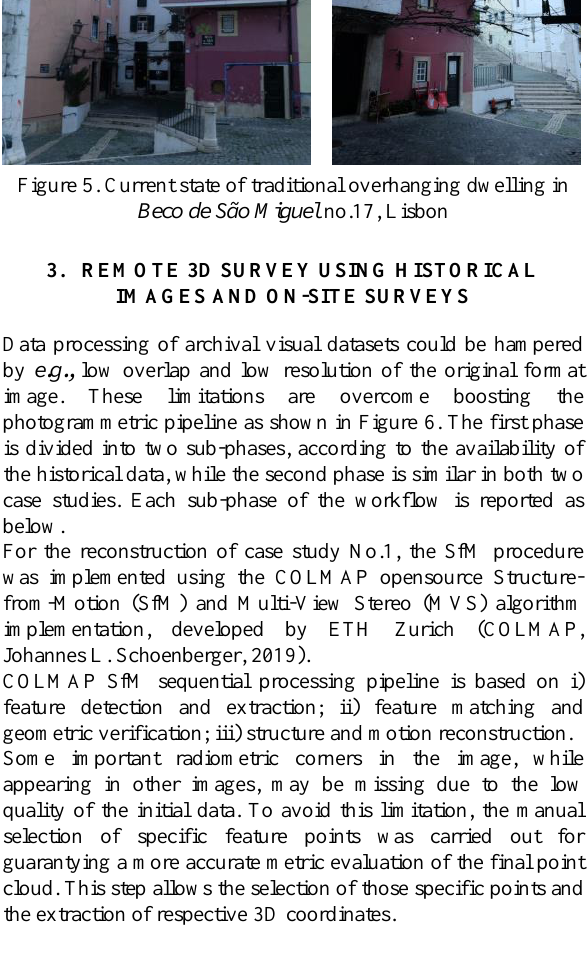
Figure 4. Archival photos of traditional overhanging dwelling in Beco de São Miguel no.17, Lisbon (1889-1908).